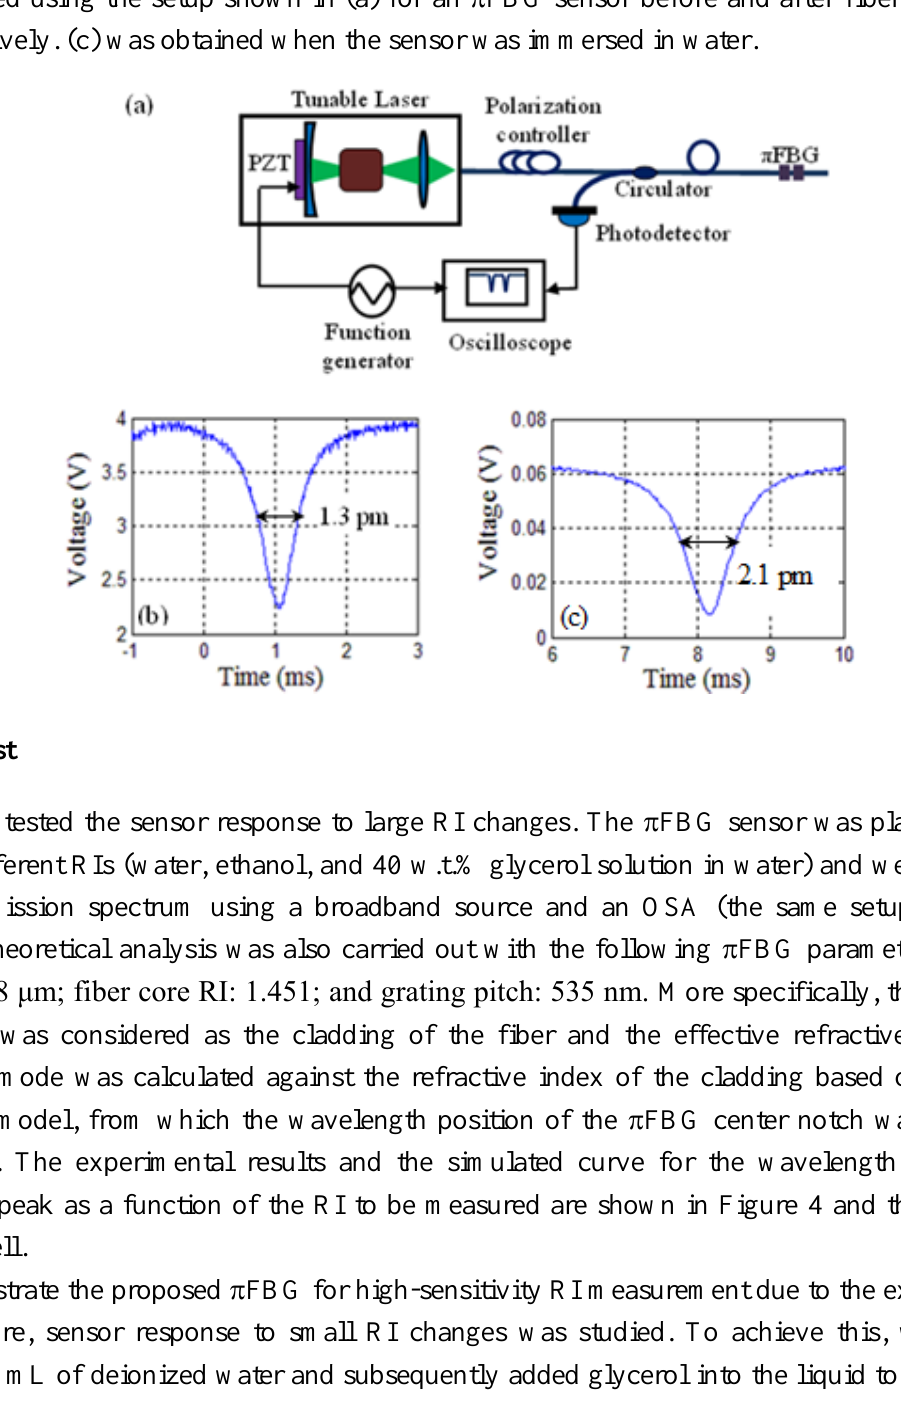
Figure 3. ( a ) Experimental setup to measure the reflection spectral notch of an  FBG sensor. The wavelength scanning speed was 1.6 pm/ms. ( b ) and ( c ) are the spectral notches measured using the setup shown in (a) for an  FBG sensor before and after fiber etching, respectively. (c) was obtained when the sensor was immersed in water.